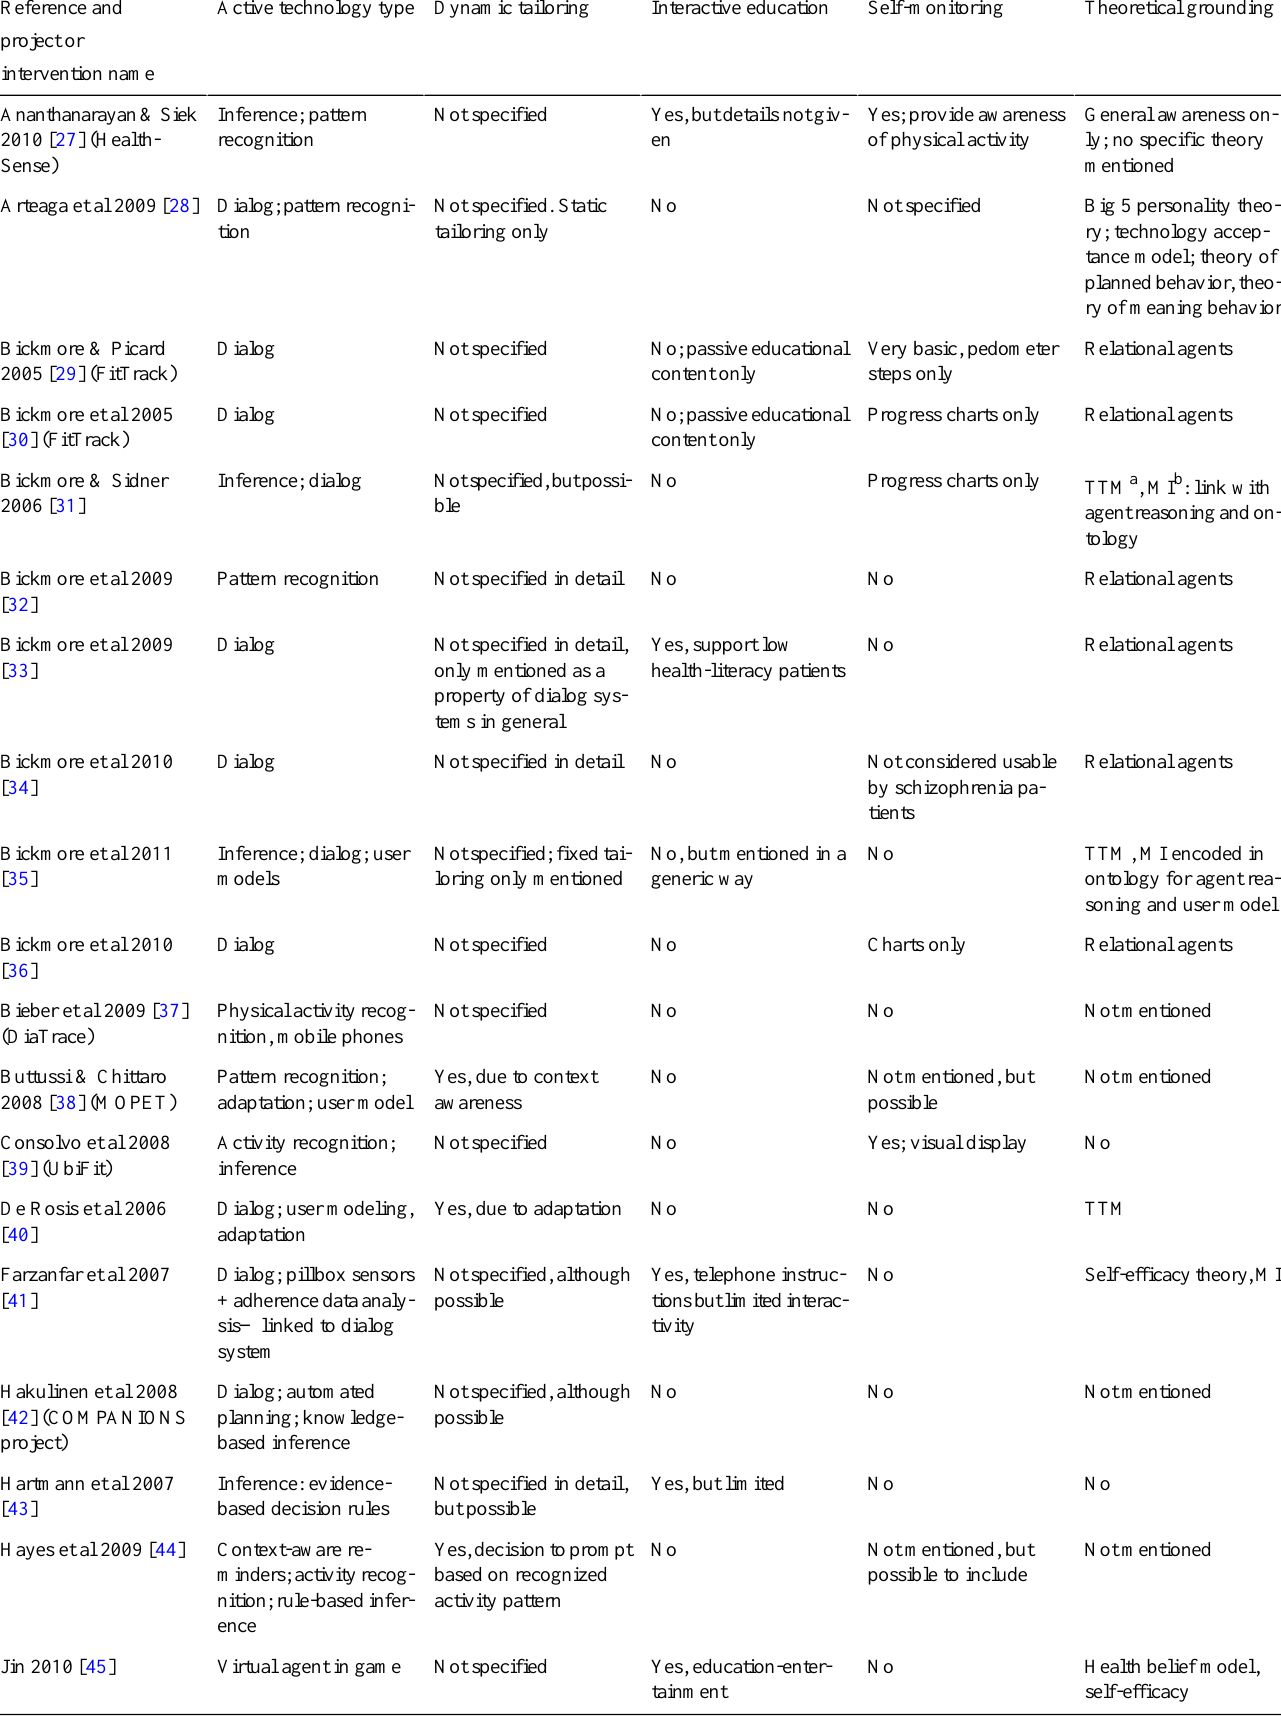
Table 2. Active technology role and theoretical